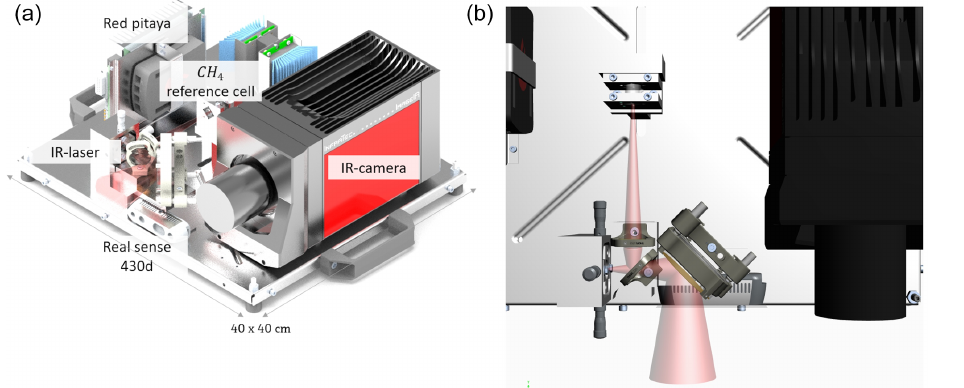
Figure 2. The setup of the real-time active-gas camera. Panel (a) presents the main components, including the infrared camera and the laser (whose beam is sketched in red), and panel (b) provides a view from the top of the instrument. Less than 1% of the laser’s light is coupled out for locking its wavelength on the target gas absorption